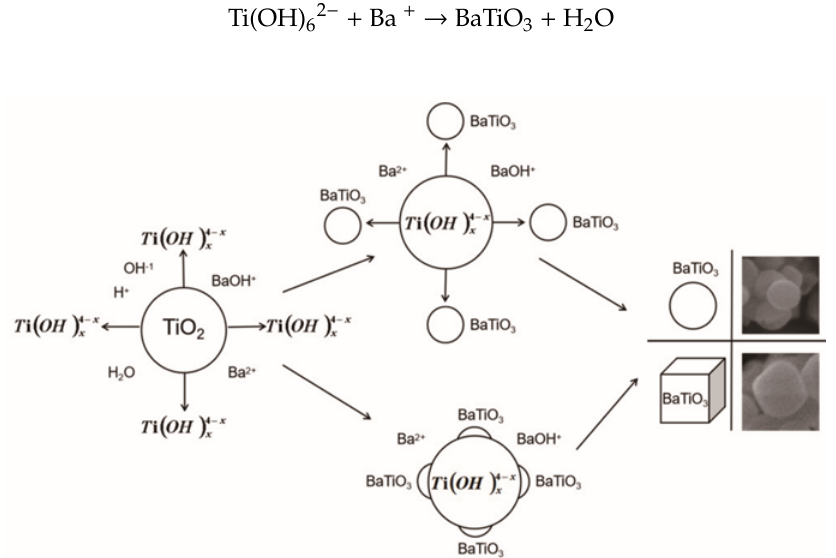
Figure 7. Possible growth mechanism for the synthesis of BaTiO 3 nanocrystals under the hydrothermal conditions using TiO 2 nanoparticles (P25) as the seeds and Ti source.